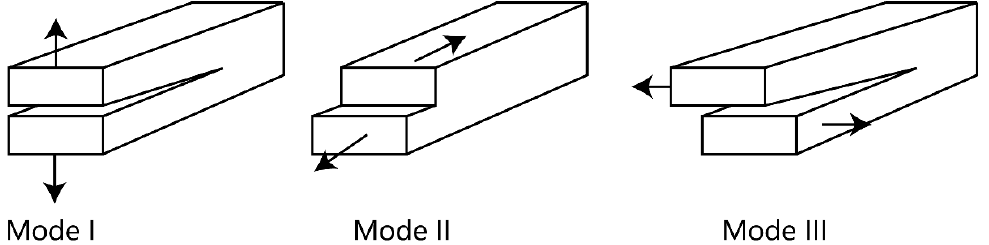
Figure 10. Three modes of loading relative to a crack: mode I (opening mode), mode II (shear or sliding mode), and mode III (tearing mode).